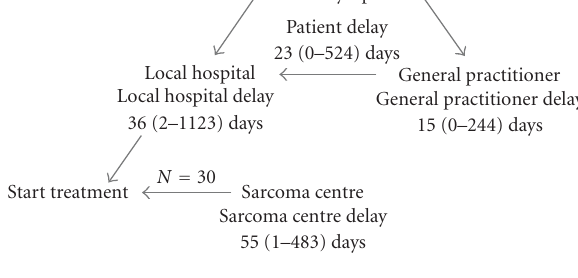
Table 1: Summary of clinicopathologic characteristics.